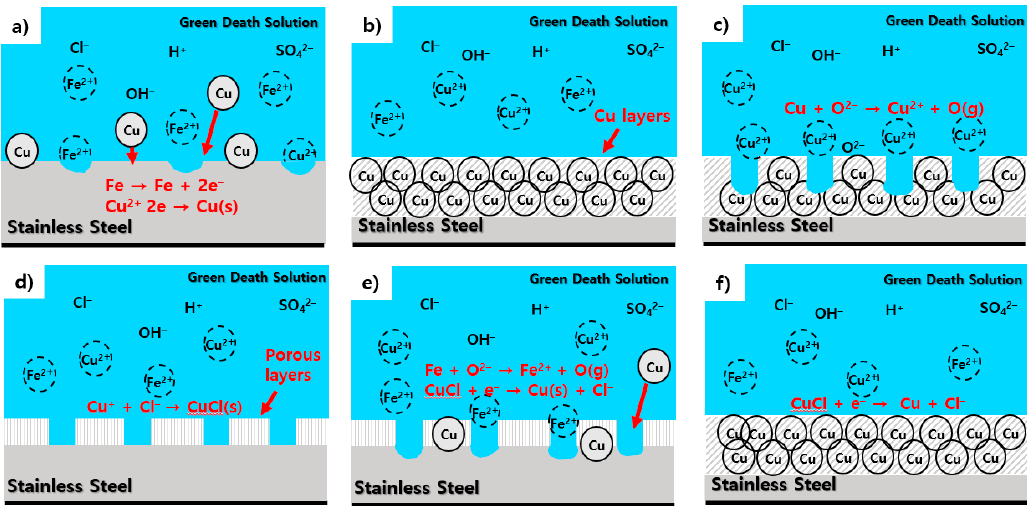
Figure 5. Schematic diagrams of the selective dissolution and redeposition mechanisms of stainless steel in a modified green death solution. ( a ) Reduction reaction of copper ion, ( b ) deposition of copper, ( c ) re-oxidation reaction of copper layer, ( d ) formation of copper chloride (porous film), ( e ) re-oxidation of substrate (Fe), ( f ) redeposition of copper (reduction reaction).